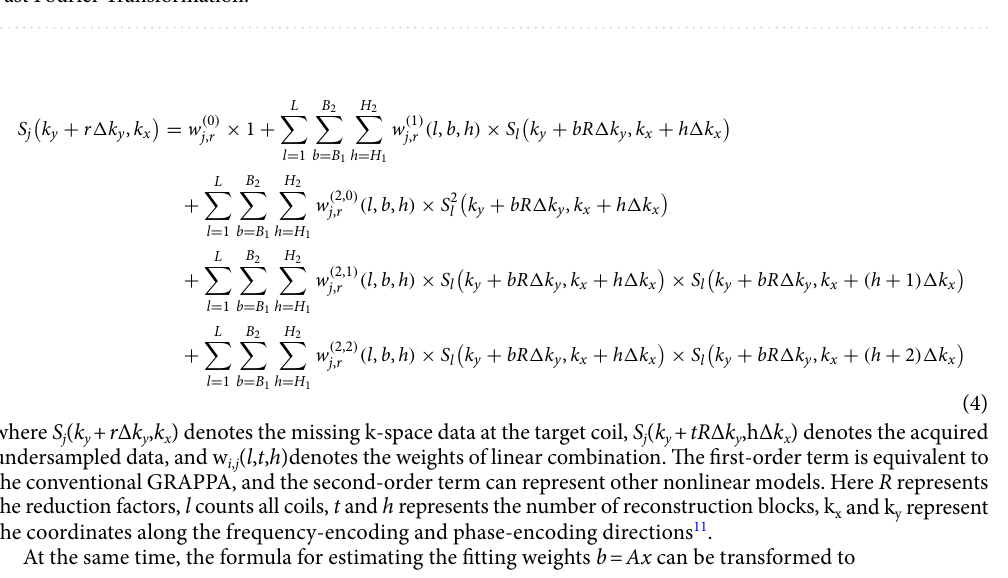
Figure 11. Comparison of fully sampled acquisition (top row) and undersampled acquisition with the acceleration factor of 2 (bottom row). Dot lines mean missing lines; solid lines are acquired lines. FFT means Fast Fourier